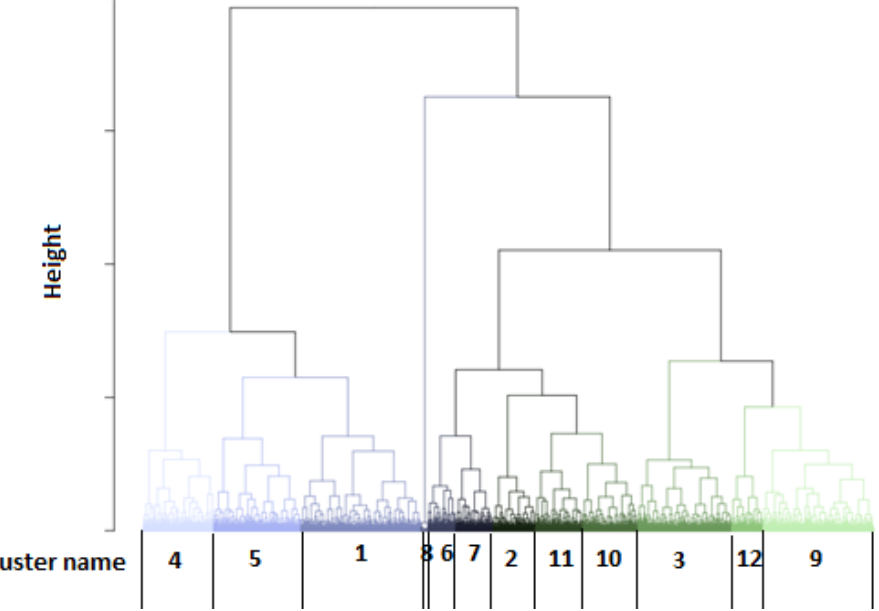
Figure 5. Evolution of the probability of belonging to the GRASS modality for the 11 studied years based on the validation set (N = 2,365,113 records).